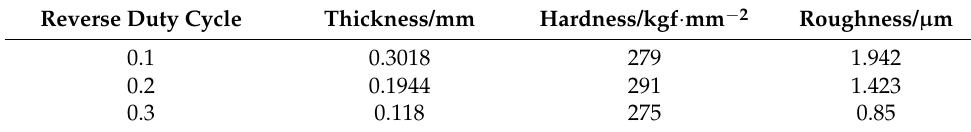
Table 3. Results of the effect of reverse duty cycle on plating properties.